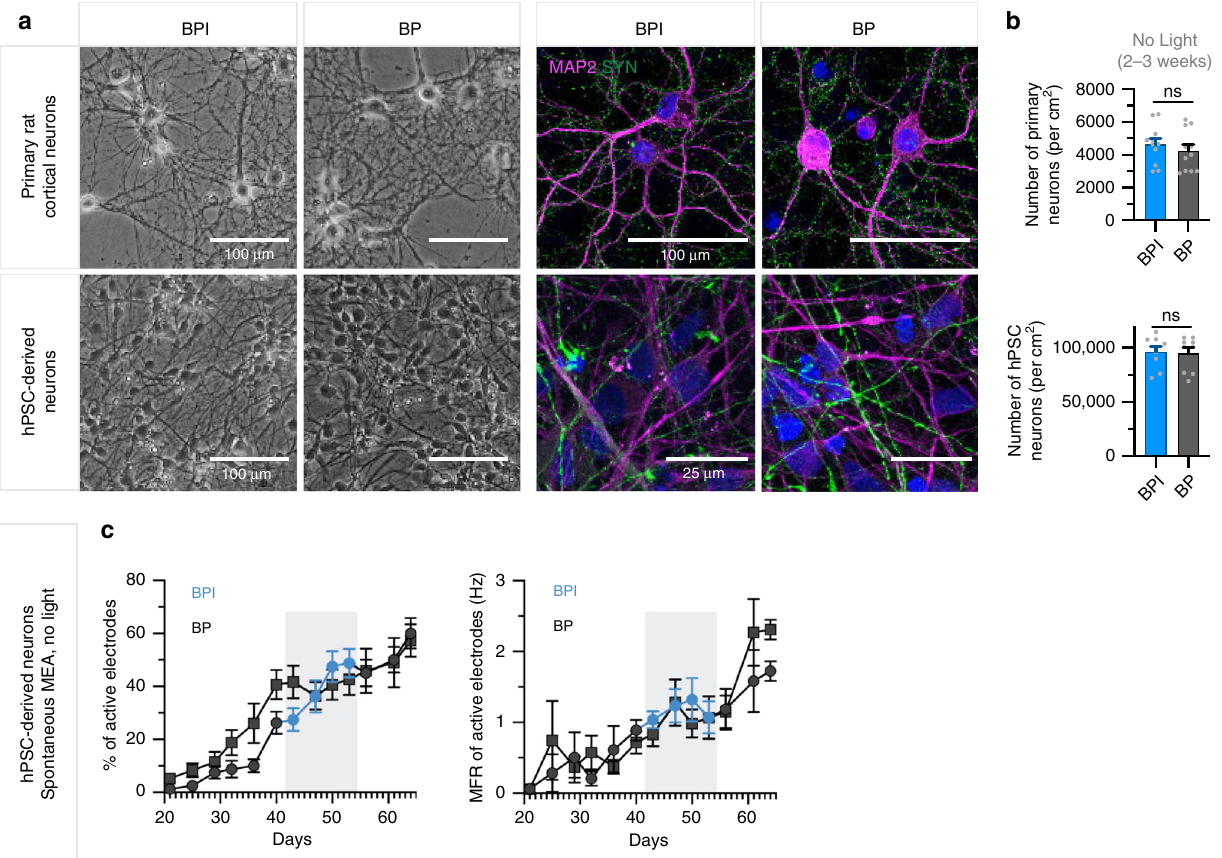
Fig. 8 BrainPhys Imaging can support long-term viability and function in vitro. a (left) Shows representative images of 14 days-in-vitro (DIV) rat cortical primary neurons and hPSC-derived neurons matured in BrainPhys (BP) and BrainPhys Imaging (BPI) exhibiting healthy neuron morphology. a (right) Representative immunocytochemistry images showing that 21 DIV primary rat cortical neurons and 14 DIV hPSC-derived neurons characterized by MAP2 expression (magenta) matured in BP or BPI also display an appropriate expression of synaptic marker Synapsin1 (green). b Quanti fi cation of the number of neurons per cm 2 as represented in a shows that BPI supports equivalent neuronal survival relative to BP for 21 DIV rat cortical primary neurons ( n = 11) and 14 – 21 DIV hPSC-derived neurons ( n = 9). Values represent mean ± SEM. Signi fi cance determined using two-tailed nonparametric unpaired (Mann – Whitney) tests; ns P > 0.05. c Multielectrode array (MEA) recordings from hPSC-derived neurons cultured in a 48-well MEA plate in BP